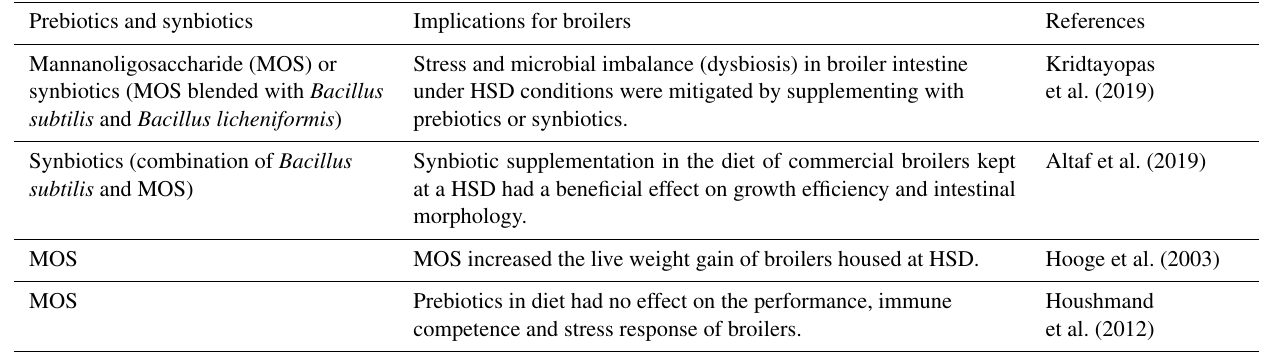
Table 2. The use of prebiotics and synbiotics in broilers raised at a high stocking density. Prebiotics and synbiotics